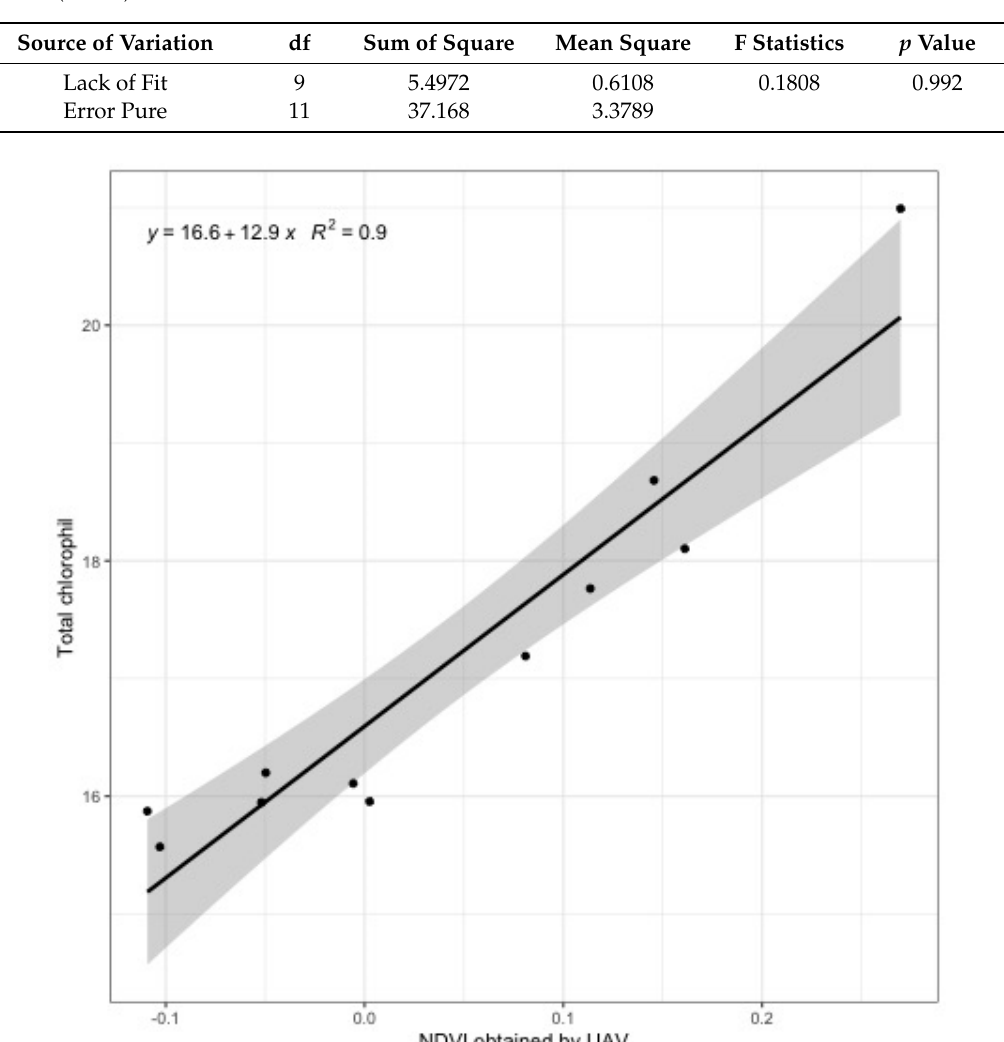
Table 3. Analysis of variance table from lack-of-fit test computed for each simple linear regression model fitted to data of total chlorophyll and infrared vegetation index: normalized di ff erence vegetation index (NDVI).